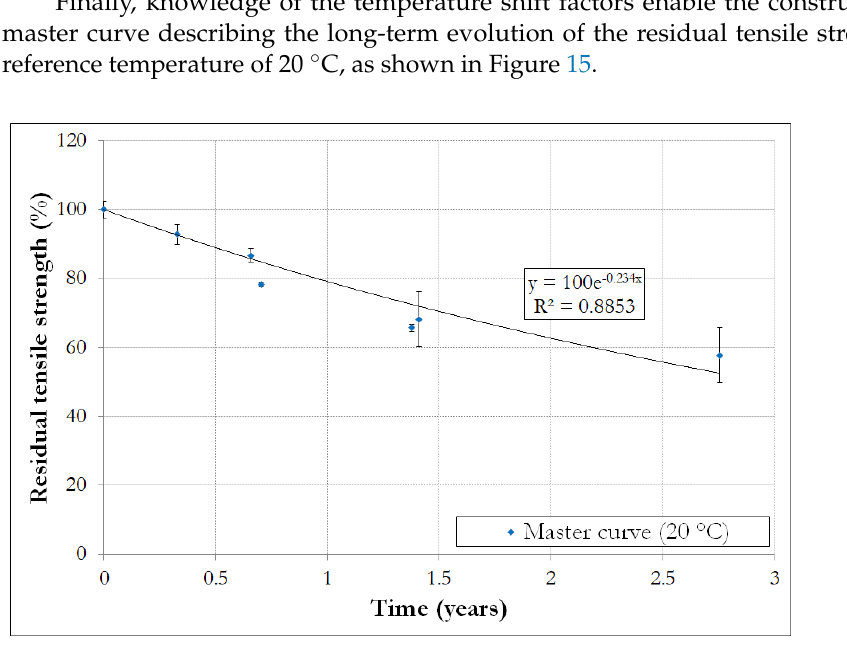
Figure 15. Master curve (residual tensile strength versus aging time) at a reference temperature of 20 °C. 20 ◦